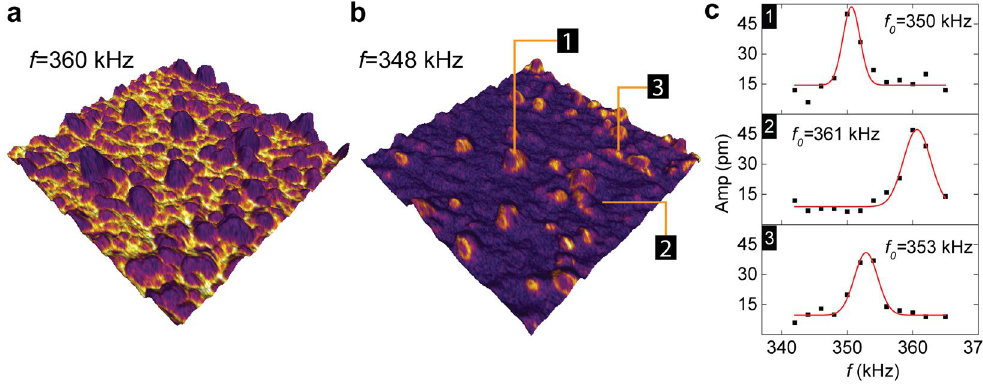
Figure 2. PFM performed on NaMnF 3 thin film. ( a,b ) 2 μ m × 2 μ m images with PFM amplitude (color) overlaid on the surface topography. The two images were taken at two different AC driving frequencies. ( c ) Frequency dependence of PFM amplitude measured at three different positions as marked in ( b ). The spatial variation of the resonance frequency ( f 0 ) leads to the non-uniform PFM response imaged.